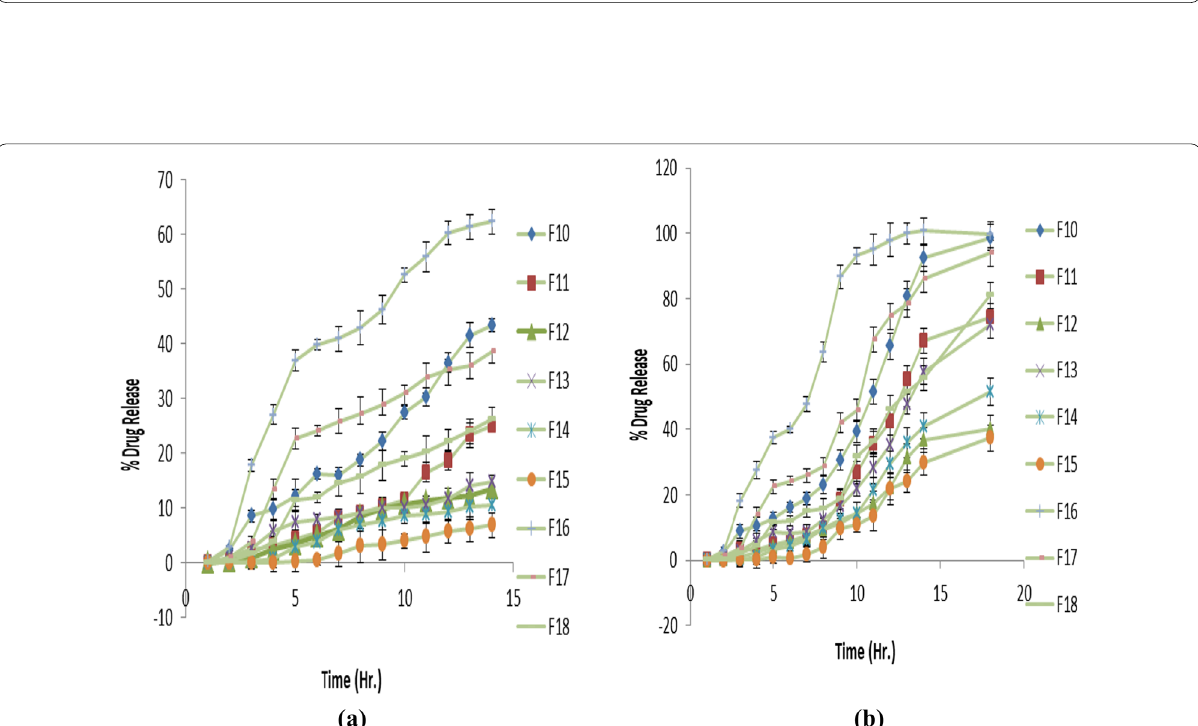
Fig. 2 In vitro drug release profiles of satranidazole pellets (Batch F1‑F9) at a simulated gastrointestinal fluid (pH 1.2, pH 4.5 and pH 7.4) and b simulated colonic fluid (pH 7)